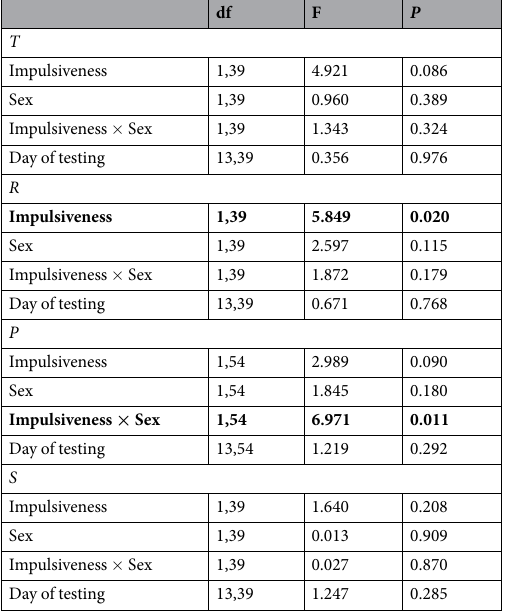
Table 2. Results from linear mixed effects analyses examining the effects of impulsiveness, sex, their interaction and testing day on the probability of cooperating after receiving payoffs T, R, P and S. Effects that remained significant after correction with the Benjamini–Hochberg procedure are shown in